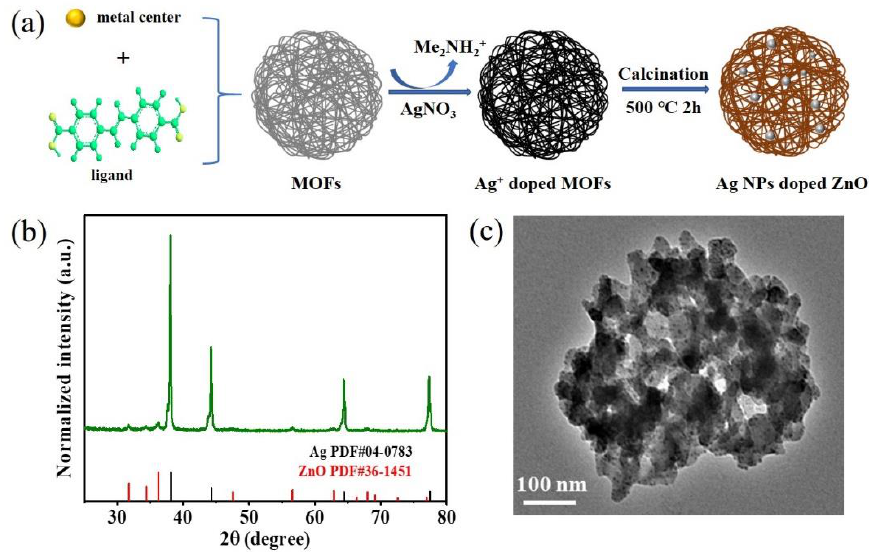
Figure 1. Ag-doped porous ZnO. ( a ) The synthesis procedures of Ag + doped MOFs via cation exchange and Ag/p-ZnO heterostructure by calcining. ( b ) XRD patterns of Ag/p-ZnO. ( c ) TEM image of sample Ag/p-ZnO.